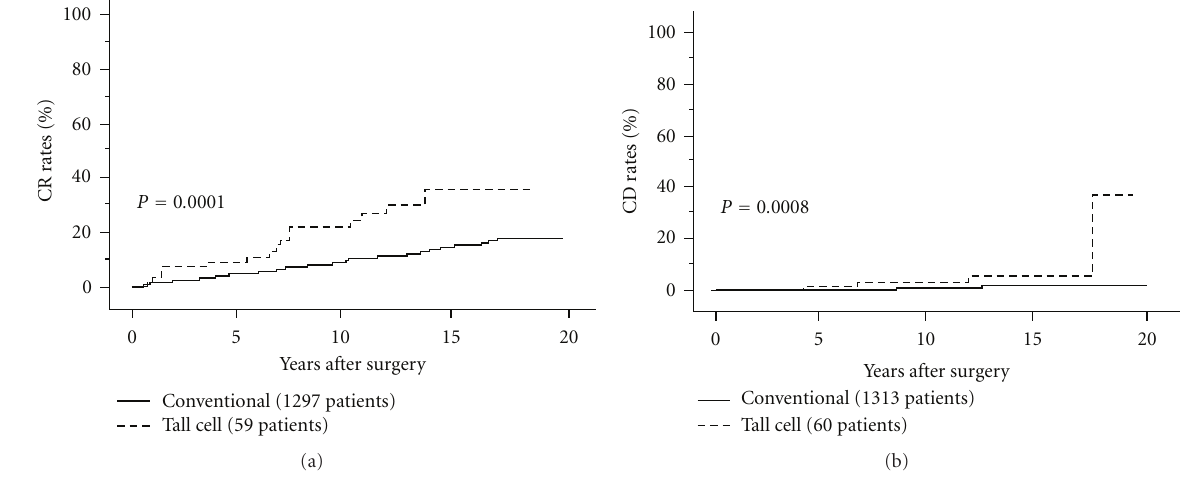
Figure 8: CR rates of tall cell variant and conventional